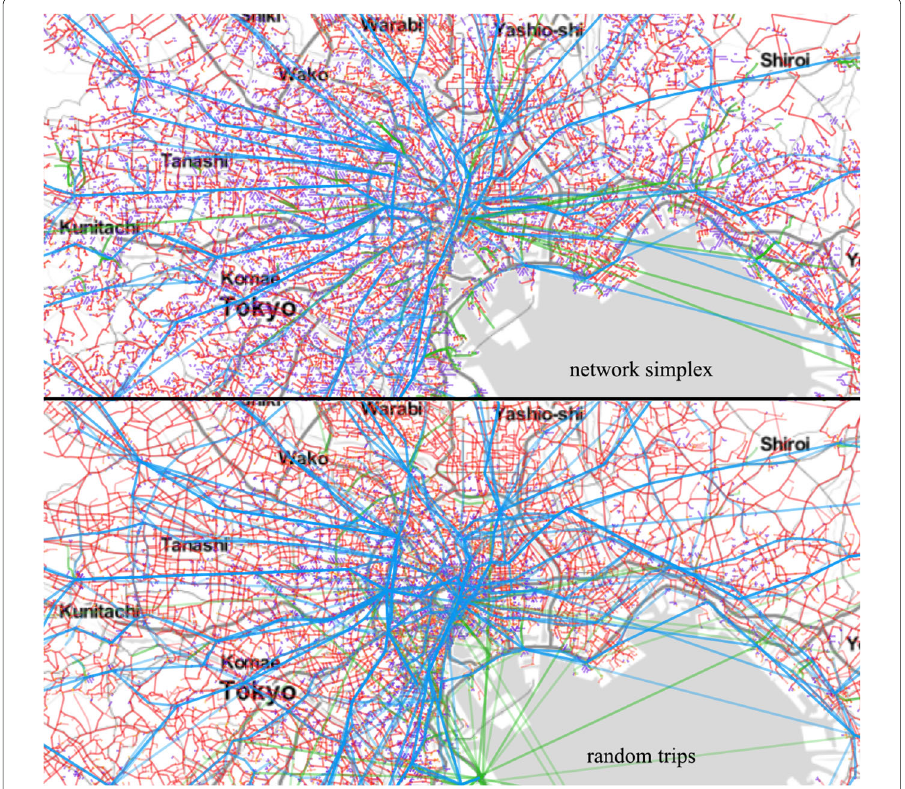
Fig. 9 A map of the Tokyo area zoomed in to show the links used by mode for the simplex algorithm (top) and generated trips to-work (bottom) filtering out edges with fewer than 10 traversals. Blue lines are trains, green are buses, red are roads, purple are interhex links, and connecting walking links are orange. Map tiles by Stamen Design (2019), map data by OpenStreetMap(OpenStreetMap Contributors